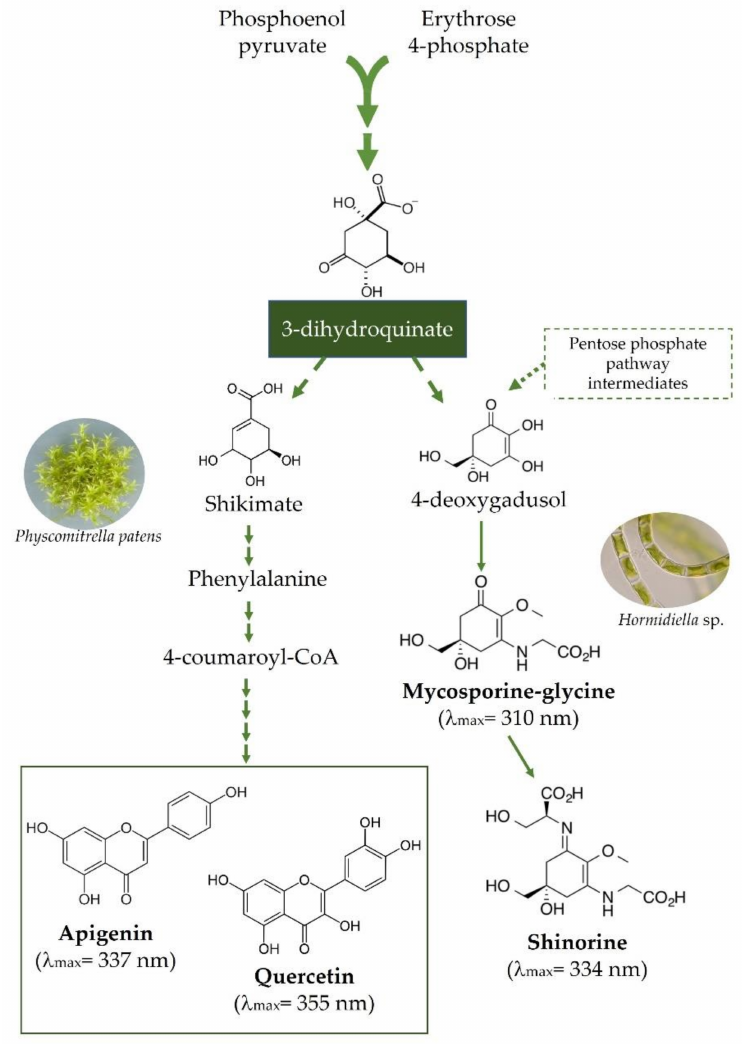
Figure 1. A synthetic diagram showing the metabolic pathways of mycosporine-like amino acids (MAAs, here exampled as the mycosporyne glycine and shinorine) and flavonoids (here represented by the flavone apigenin and the flavonol quercetin). The two pathways diverge early in the shikimate pathway. Mycosporyne glycine and shinorine have, on average, molar extinction coefficients 80% higher than those of apigenin and quercetin over the UV-B portion of the solar spectrum (280–315 nm, G. Agati personal